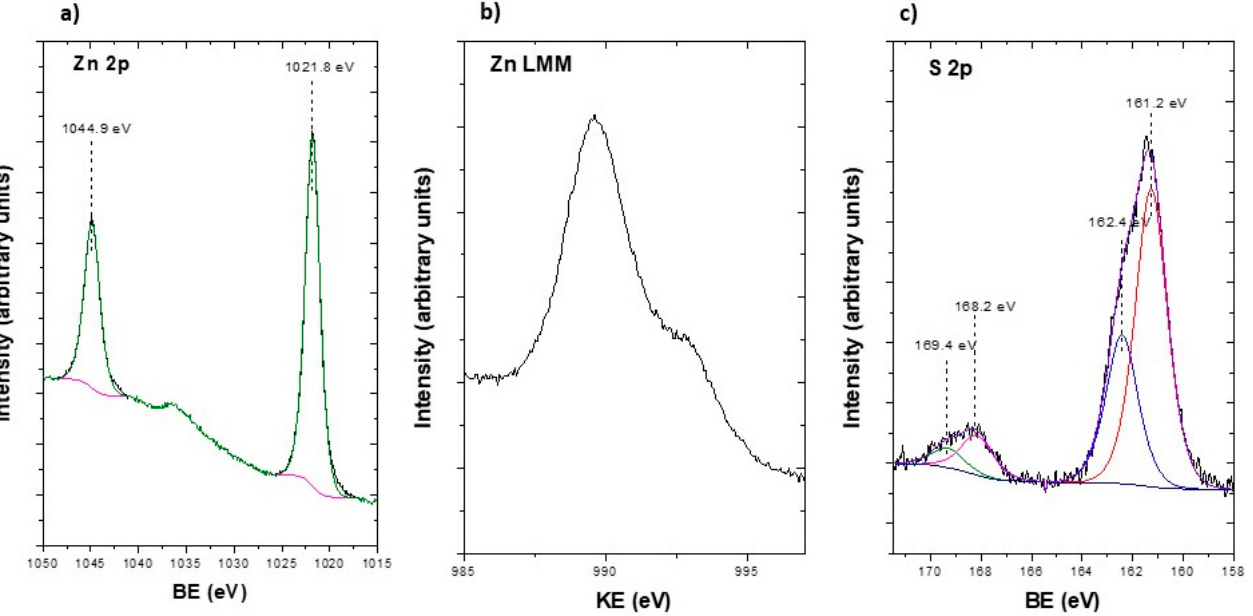
Figure 5. ( a ) Zn 2p ( b ) Zn LMM Auger transition and ( c ) S 2p XPS spectra of ZnS nanoparticles, respectively.